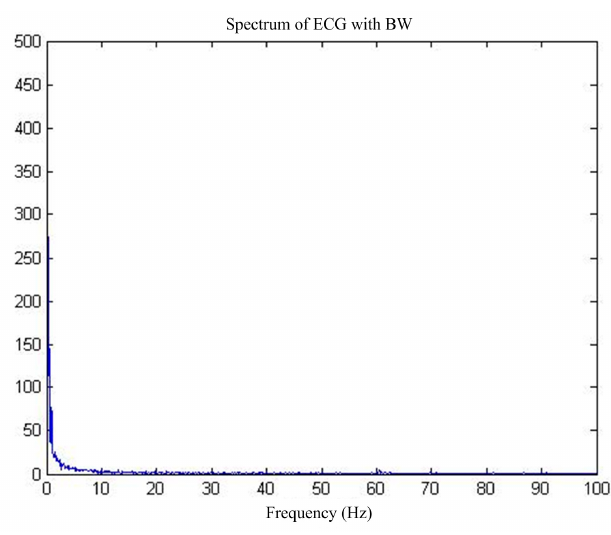
Figure 14. MIT-BIH ECG before and after BW.